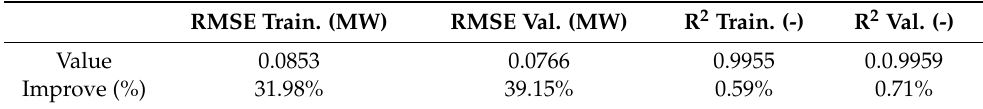
Table 3. Computed RMSE and R 2 index values for 15-neuron FFNN